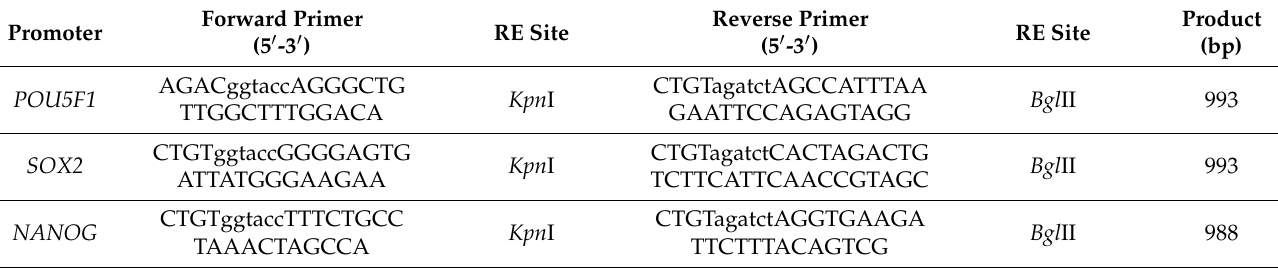
Table 4. The mutagenesis was carried out according to the manufacturer’s instructions. Table 3. Cloning primers for chosen Homo sapiens stemness gene promoters.